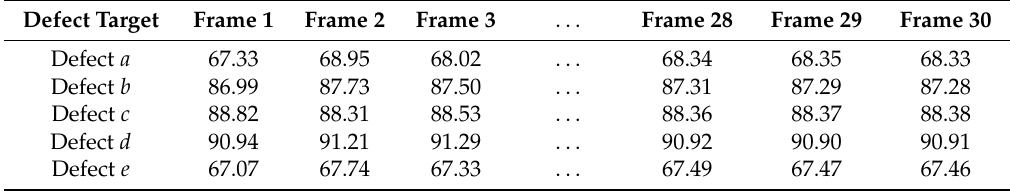
Table 2. The results of defect depth calculation of surface defect